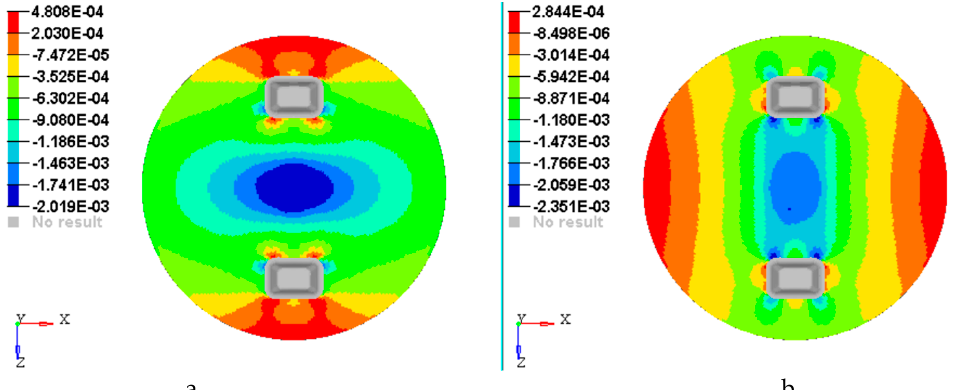
Figure 17. Plot strain on the interface between layer 4 and 5: ( a ) Strains x ε with respect to Ox axis; ( b ) strains z ε with respect to Oz axis.